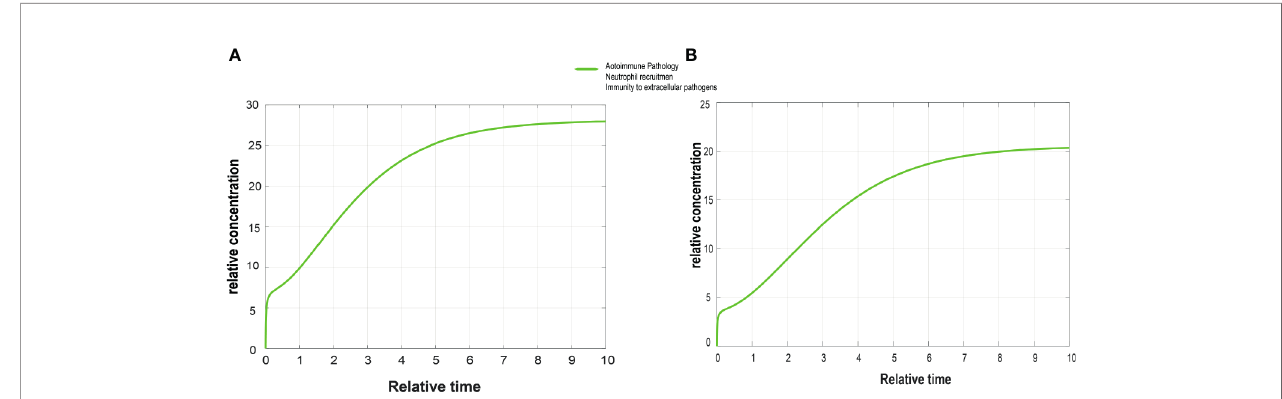
FIGURE 5 | Simulated graphs of autoimmune pathology, neutrophil recruitment, and immunity to extracellular pathogens. The x-axis represents time, whereas y-axis depicts concentration. (A) Simulated graph of autoimmune pathology, neutrophil recruitment, and immunity to extracellular pathogens in psoriasis. In psoriasis, activation of autoimmune pathology, neutrophil recruitment, and immunity to extracellular pathogens start immediately and reach their peak value around 28 in 9.5 time units and become constant after it. (B) Simulated graph of autoimmune pathology, neutrophil recruitment, and immunity to extracellular pathogens in cSCC. Autoimmune pathology, neutrophil recruitment, and immunity to extracellular pathogens activate immediately in cSCC and reach their peak value around 21 in 10 time